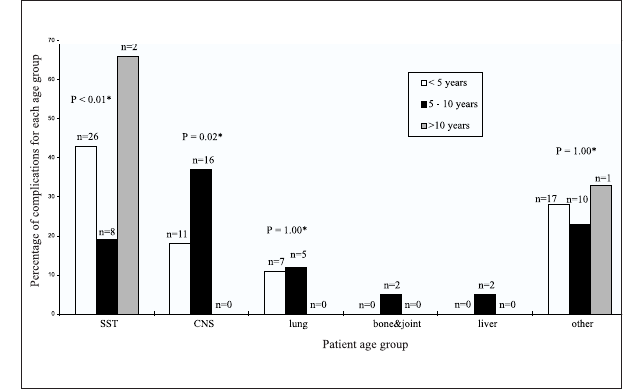
Figure 3) Anatomical sites among patients with complications by pa- tient age group. *Comparisons were made between children younger than five years of age and children aged five to 10 years, given the small number of children older than 10 years of age. CNS Neurological complications; SST Skin and soft tissue